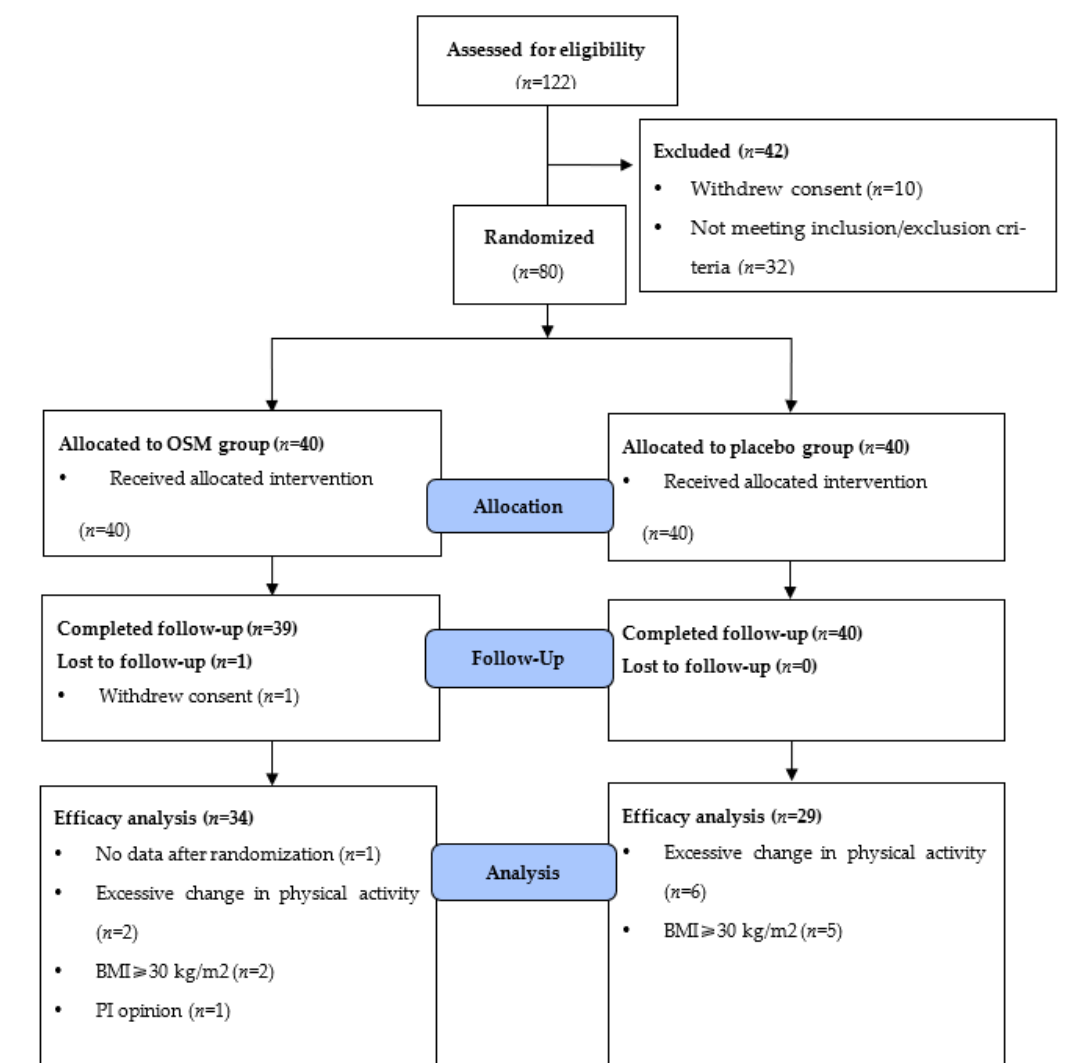
Figure 1. Flow-chart of the participants.